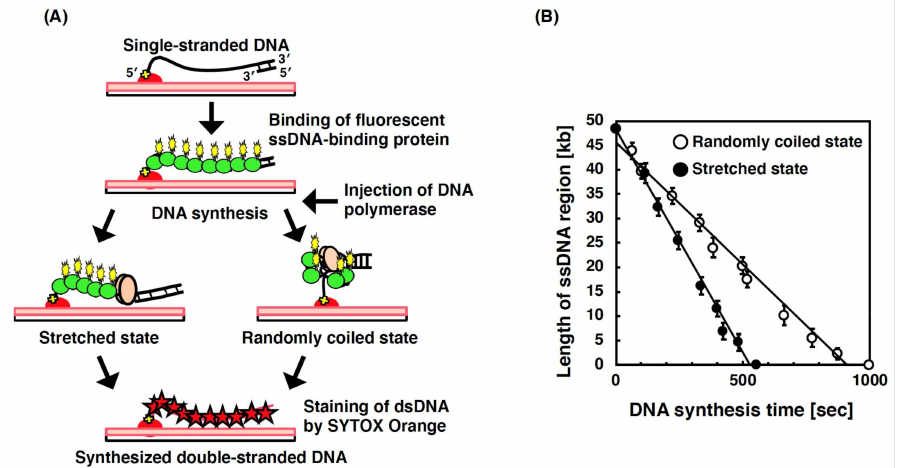
Figure 10. Analysis of the single-molecule imaging of the activity of DNA polymerase on single DNA molecules. ( A ) Schematic illustration of the DNA synthesis by DNA polymerase at a single-molecule level. One end of template ssDNA for DNA synthesis was specifically immobilized on a modified glass surface, and then, fluorescently labeled RPA molecules were injected into the flow cell, resulting in the binding of fluorescently labeled RPA to the ssDNA molecules. During DNA synthesis by DNA polymerase, the DNA tensions under the randomly coiled state and stretched state were controlled in the presence or absence of fluid flow. After the DNA synthesis, the dsDNA synthesized from ssDNA was stained by SYTOX Orange, allowing visualizing under a fluorescence microscopic field. ( B ) Time course for the length of the single-stranded regions of the single DNA molecules under the relaxed and stretched states during DNA synthesis by Klenow fragment (3 (cid:48) –5 (cid:48) exonuclease). Closed circles and open circles indicate the length of the single-stranded region on stretched ssDNA and that on relaxed ssDNA, respectively. Refer to [183] for